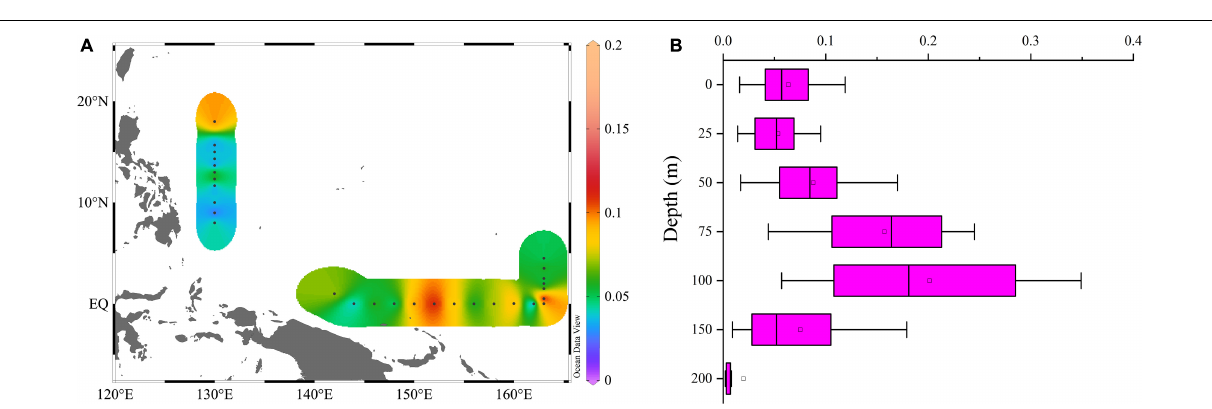
FIGURE 9 | Horizontal (A) and vertical (B) distributions of pico-Chl a ( µ